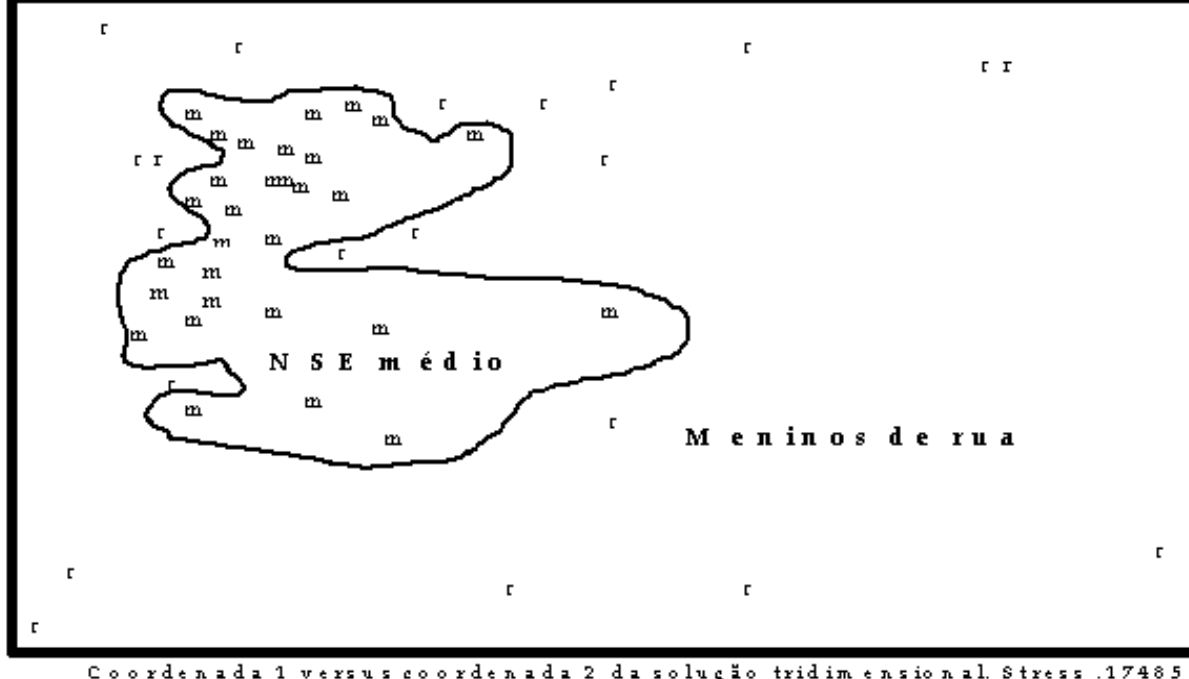
Figura 7 . Análise SSA comparativa entre os grupos NSE médio e Meninos de rua a partir dos perfis relativos às ordenações das ocupações em função da remuneração.